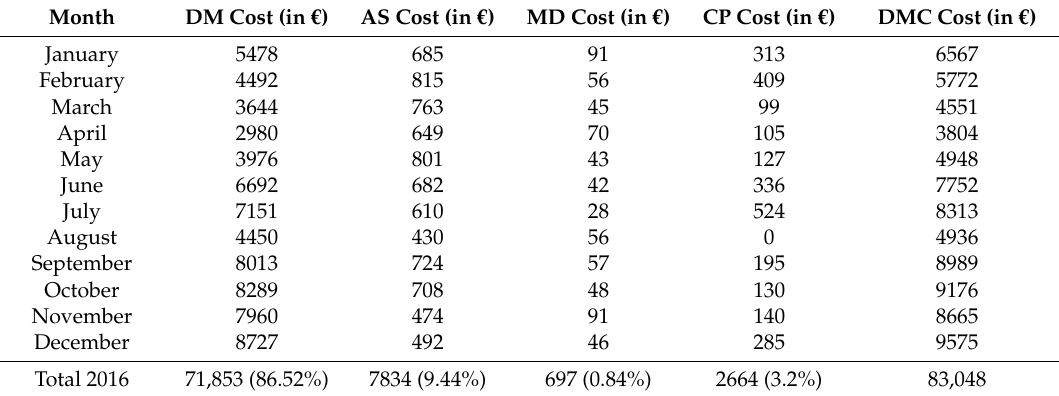
Table 9. Monthly cost acting as a Direct Market Consumers (DMC) and its